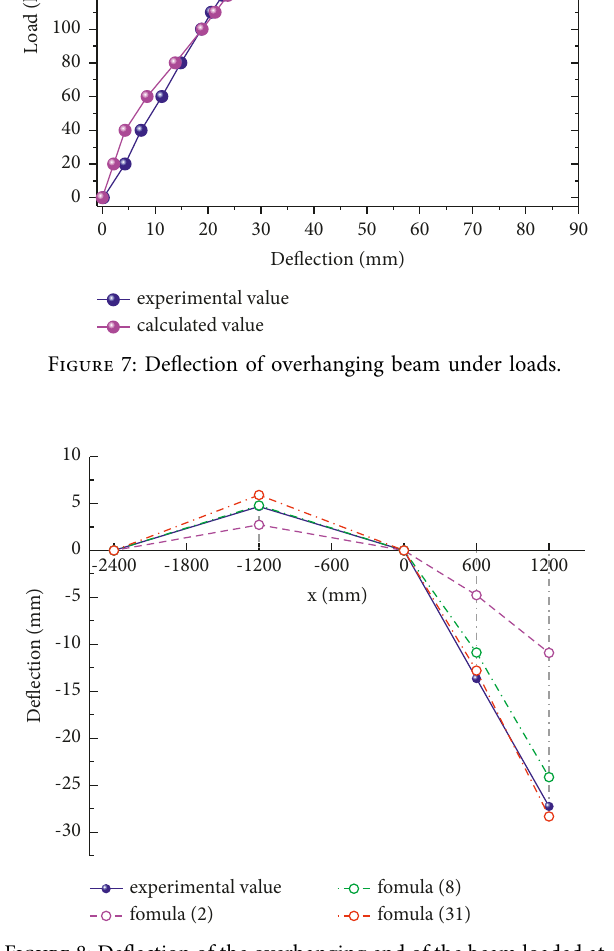
Figure 8: Deflection of the overhanging end of the beam loaded at 140kN.